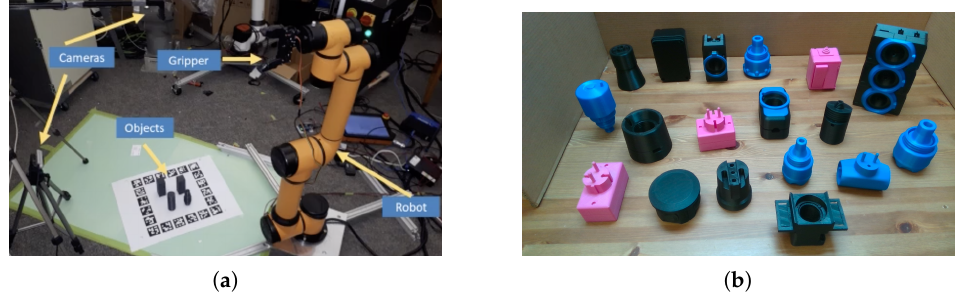
Figure 2. ( a ) Our experimental setup. The images from the top view camera provide an initial estimate of the ROI and the images from the perspective view camera provide the final object detection and recognition. ( b ) Some of the textureless objects we used. All of the objects are 3d printed from